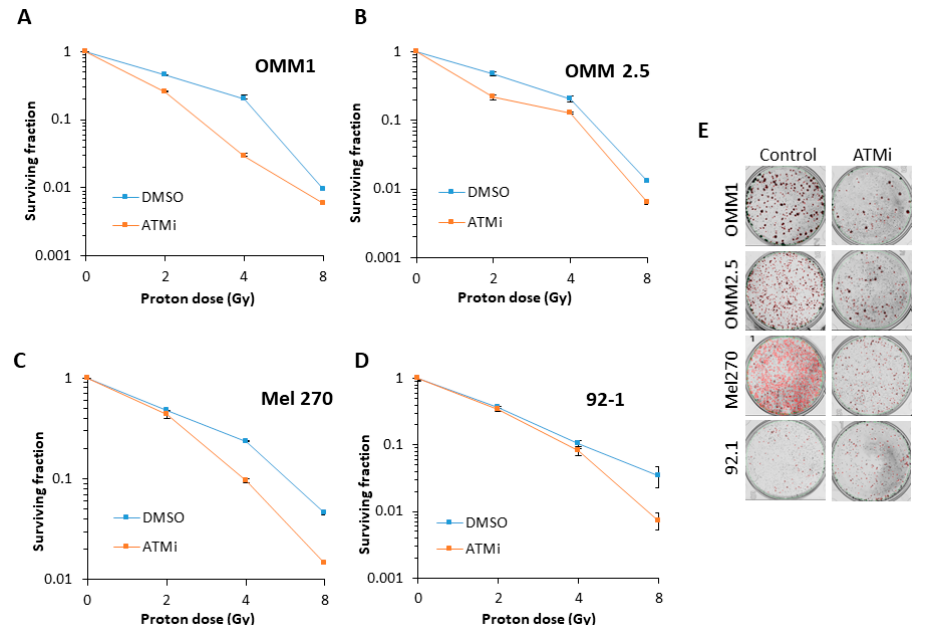
Figure 4. Comparative radiosensitivity of UM cells in the presence of ATM inhibition, following proton irradiation. The clonogenic survival of UM cells with ATM inhibition in the presence of increasing doses of protons was analyzed from three independent experiments. ( A – D ) Shown is the surviving fraction ± S.E. ( E ) Representative images of colonies in non-irradiated and irradiated (4 Gy) plates (the latter were seeded with double the number of cells, accordingly).